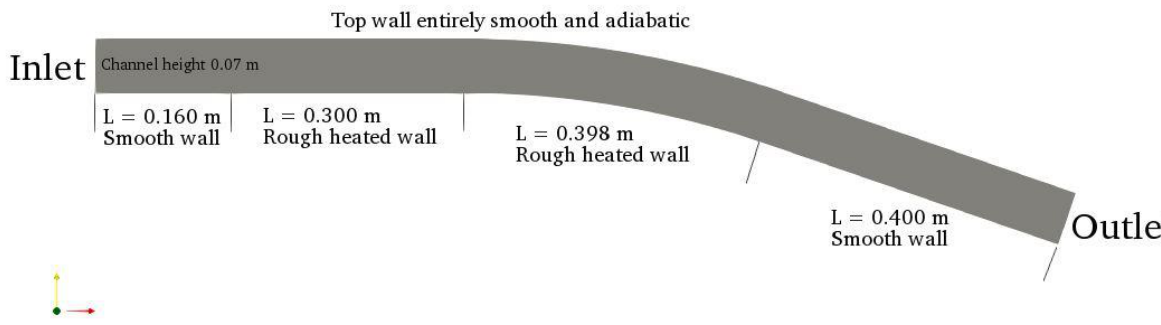
Figure 1. Geometry of the curved channel. The curved part of the channel’s floor, whose curvilinear length is 0.398 m, is an arc of radius 1.200 m and an angle of 19 ◦ . The freestream values are a velocity